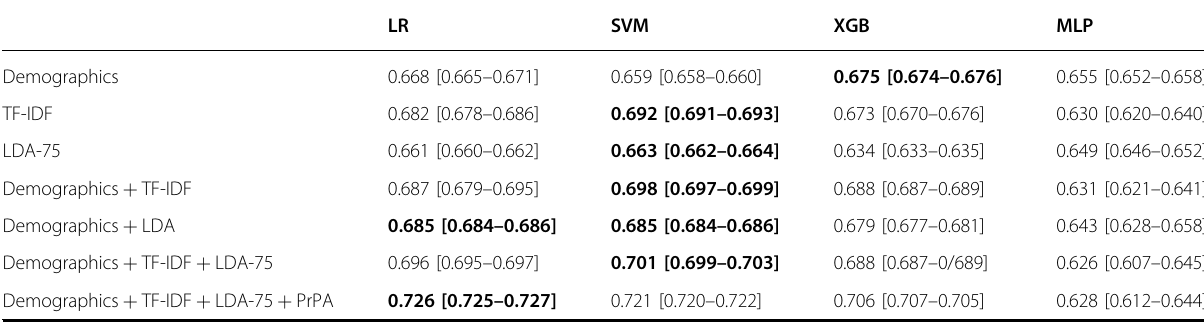
Table 2 Overall performance of the tested models.